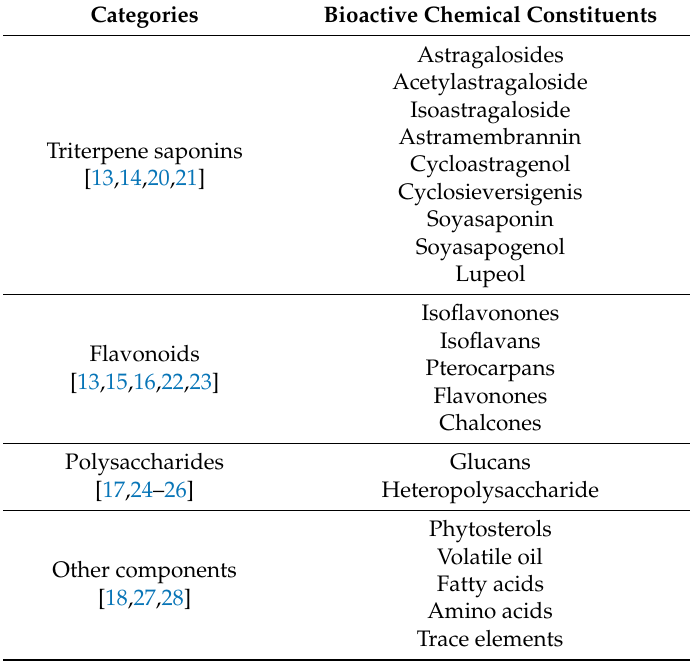
Table 1. Representative extracts of